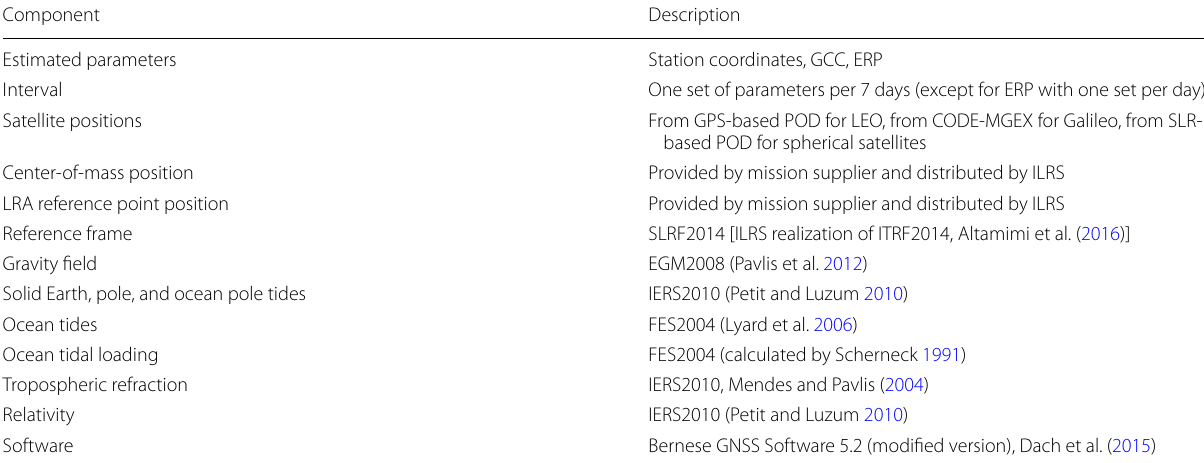
Table 3 List of tested solutions in the processing